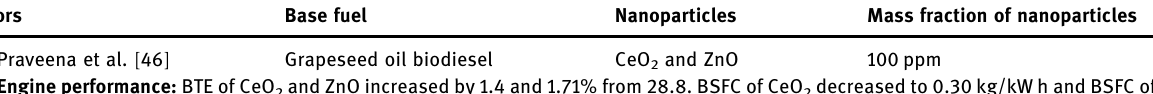
Grapeseed oil biodiesel CeO 2 and